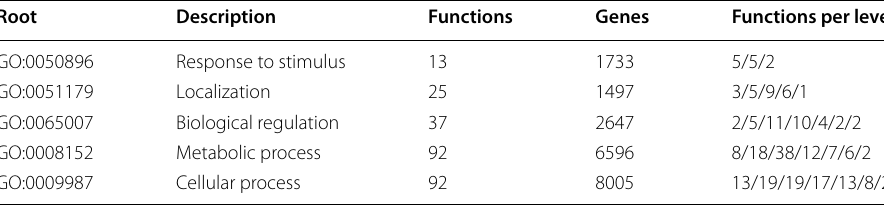
The identifier and description of each root function r is presented in the first and second columns, respectively. The third column shows the number of functions A ′ within each sub‑hierarchy and the fourth column shows the number maize genes in the GCN subgraph G ′ associated to H ′ . The last column shows the number of functions per level, e.g., the first sub‑ hierarchy has 3 levels and there are 5, 5, and 2 functions on each level